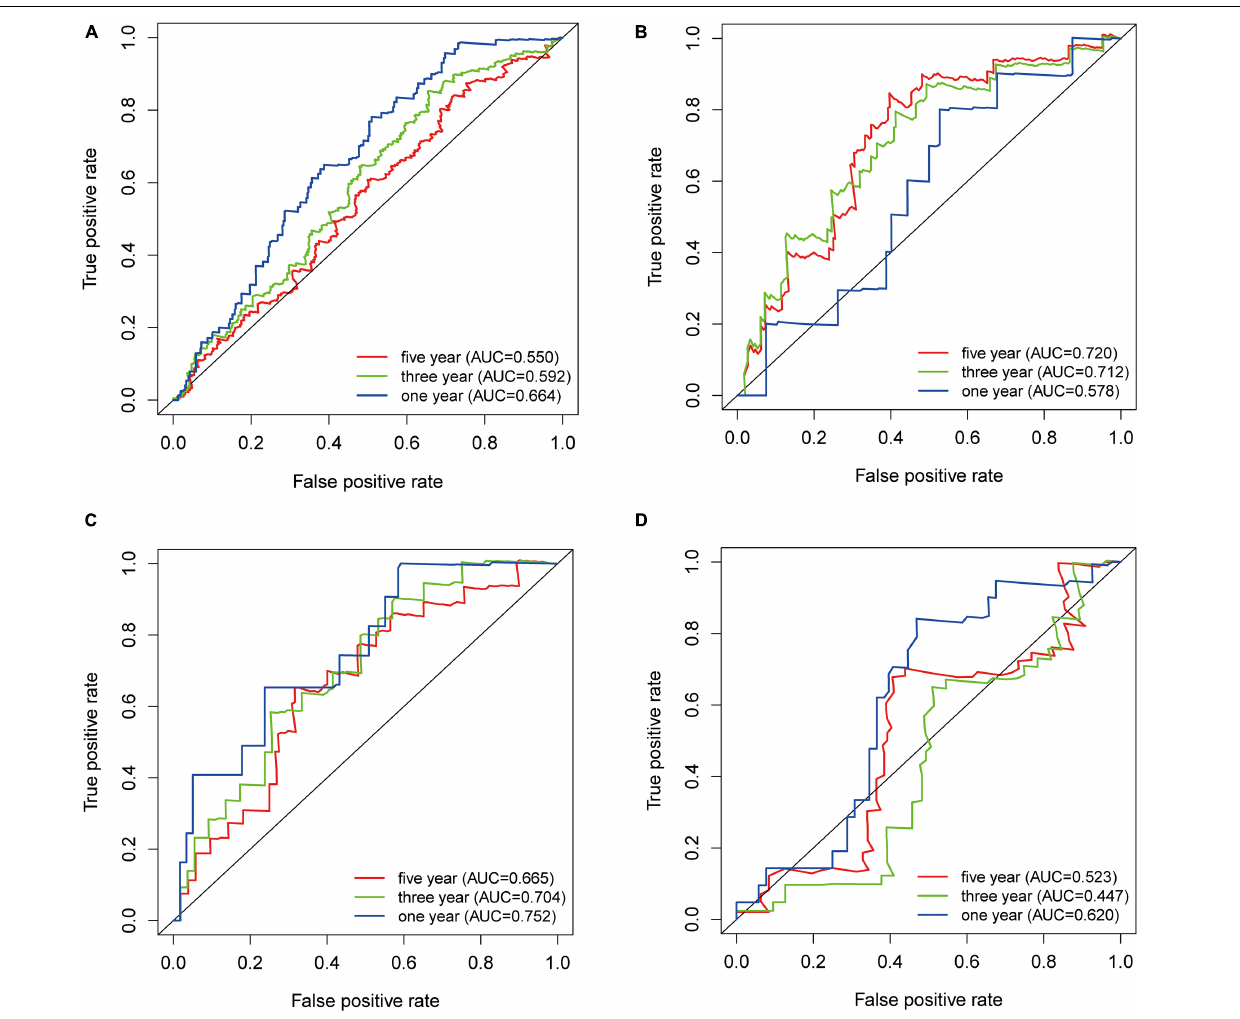
FIGURE 2 | ROC curve. (A) TCGA-BLCA. (B) GSE32894. (C) GSE32548. (D) E-MTAB-1803. The blue, green, and red lines represent the ROC curve of 1-year, 3-year, and 5-year overall survival